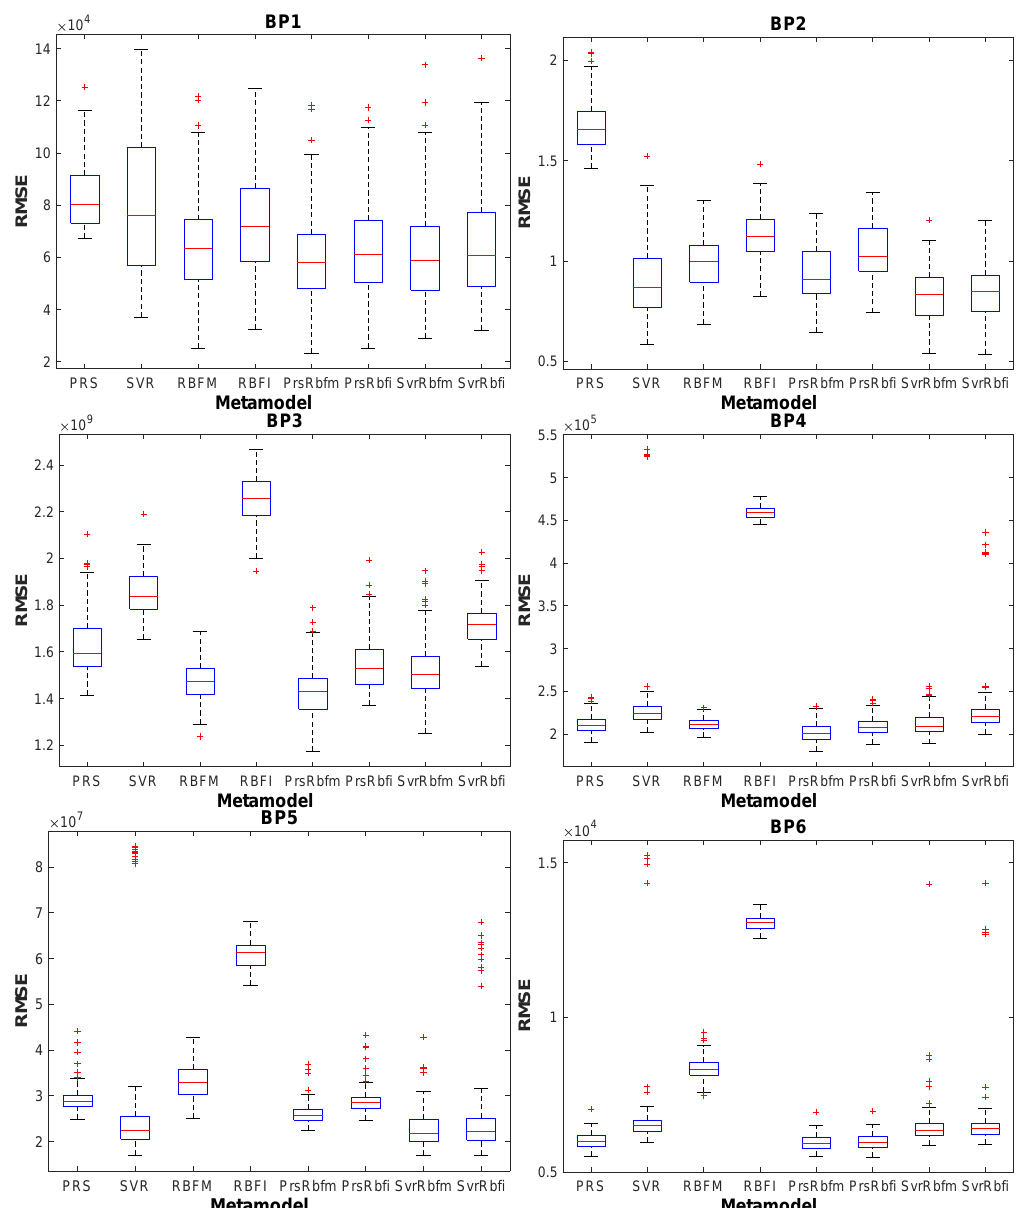
Figure 2. Boxplots of RMSE of the metamodels over 100 test sets for each benchmark problem with 3 ( k + 1 )( k + 2 ) training 2